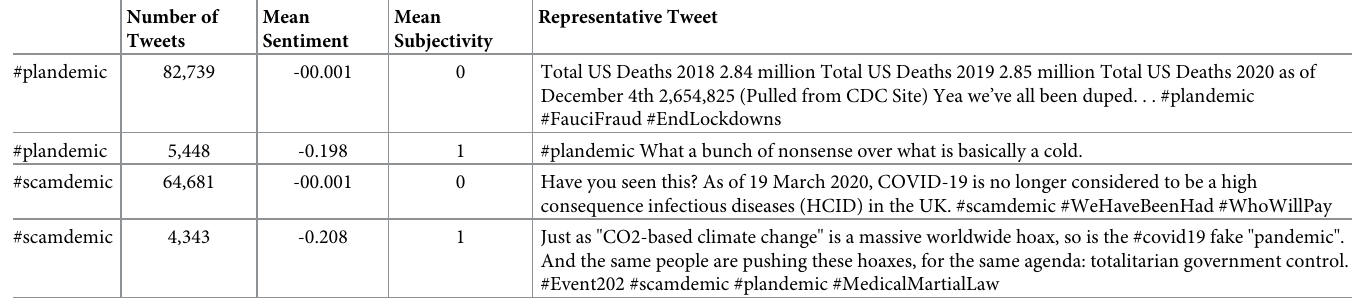
Table 3. Example tweets with subjectivity and sentiment scores for each hashtag. Number of